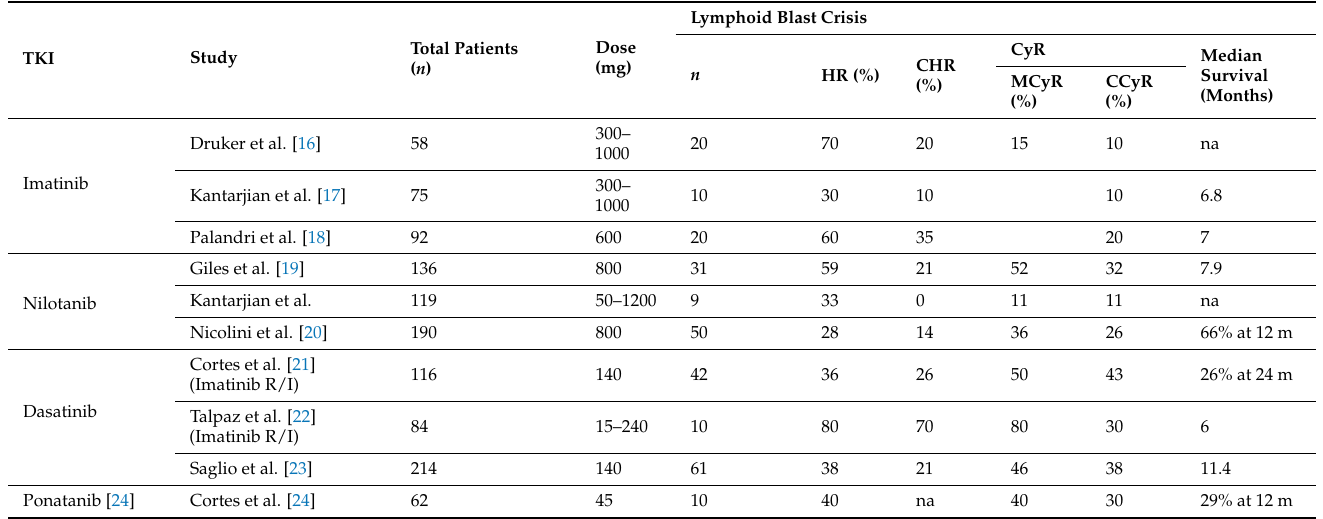
Table 1. Various TKIs in patients with Lymphoid Blast